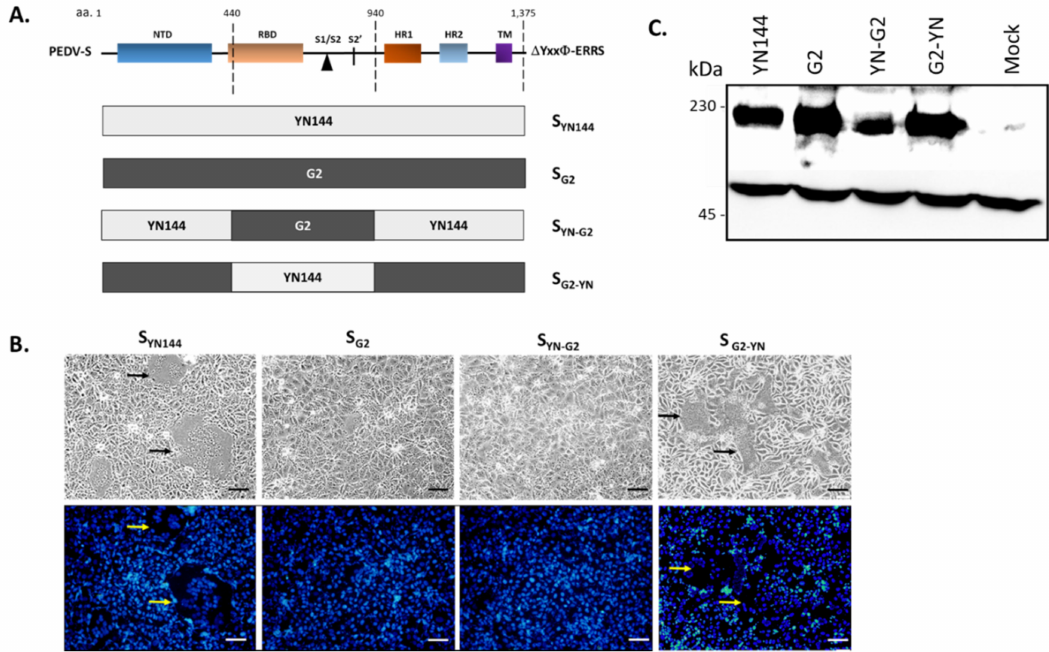
Figure 3. Syncytium formation in VeroE6-APN cells expressing chimeric S YN144 bearing receptor binding domain (RBD) and S1/S2 cleavage of S G2 . ( A ) Schematic representation of chimeric PEDV S ( B ) VeroE6-APN cells were transfected with pCAGGS expressing S YN144 , S G2 , or the chimeric S YN-G2